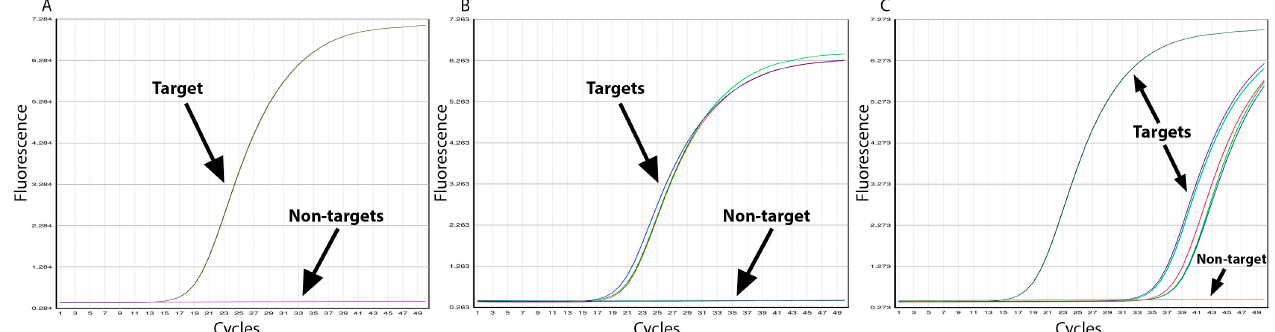
Figure 2. Evaluation of analytical specificity of the C. papaya assay. Graphs show: ( A ) positive am- plification of one target papaya BRM (3787) and 21 unamplified non-target species, ( B ) positive am- plification of three target fresh papaya samples (PB–1, PG–1, PL–1) and one unamplified negative control non-target, and ( C ) positive amplification of one fresh papaya sample (BRM697), five pro-